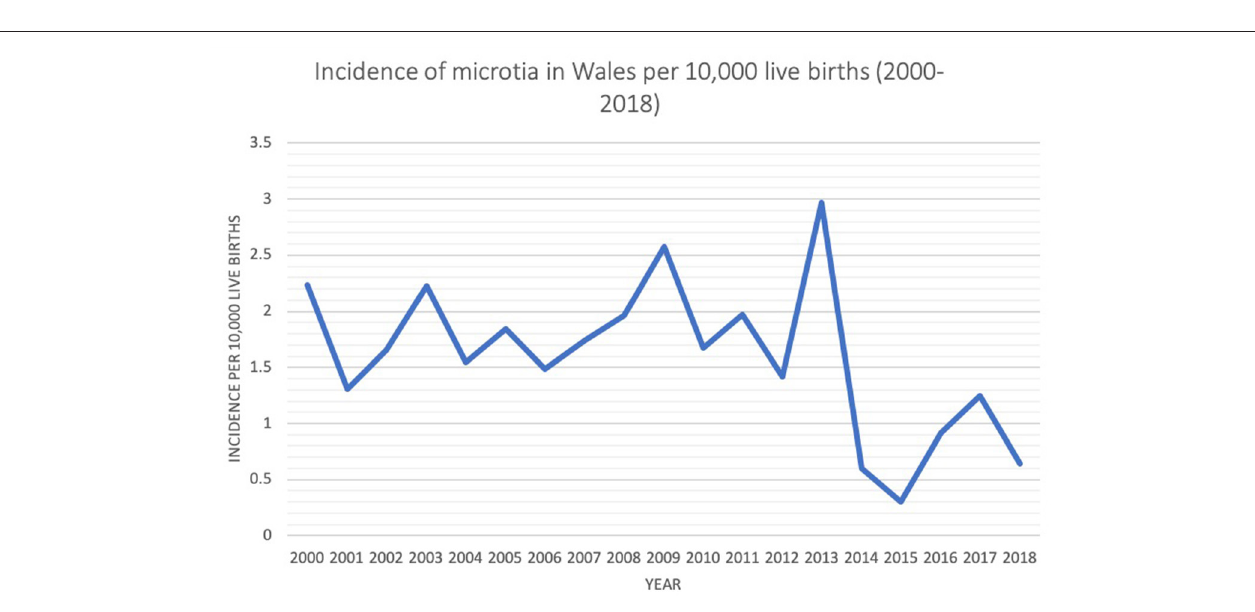
FIGURE 2 | Annual incidence of microtia in Wales during study period 2000–2018.